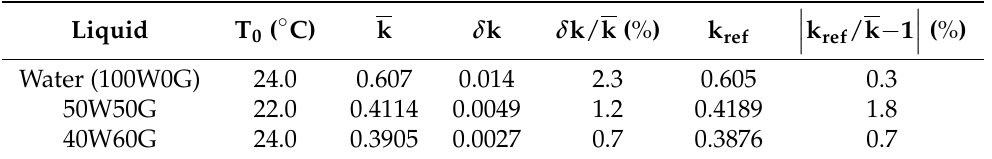
Table 5. Determination of the thermal conductivities of several liquids (pure water and water– glycerol mixtures) by the present 1D ESM approach, with: k the mean value of measurements, √ N − 1 the standard error of measurement, σ k the standard deviation of measurements, δ k = σ k / and k ref the reference thermal conductivity value (all these quantities are given in W · K − 1 · m − 1 ).